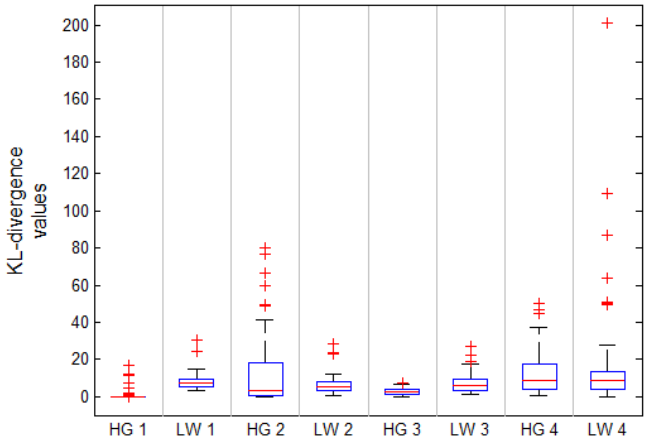
Figure 9. KL-divergences of HMP-GMR (HG) and likelihood weighting (LW) for four CLG BNs.